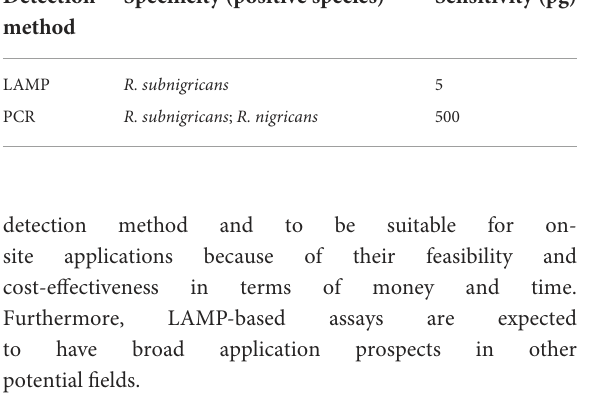
TABLE 4 Specificity andsensitivity detection results of R. subnigricans